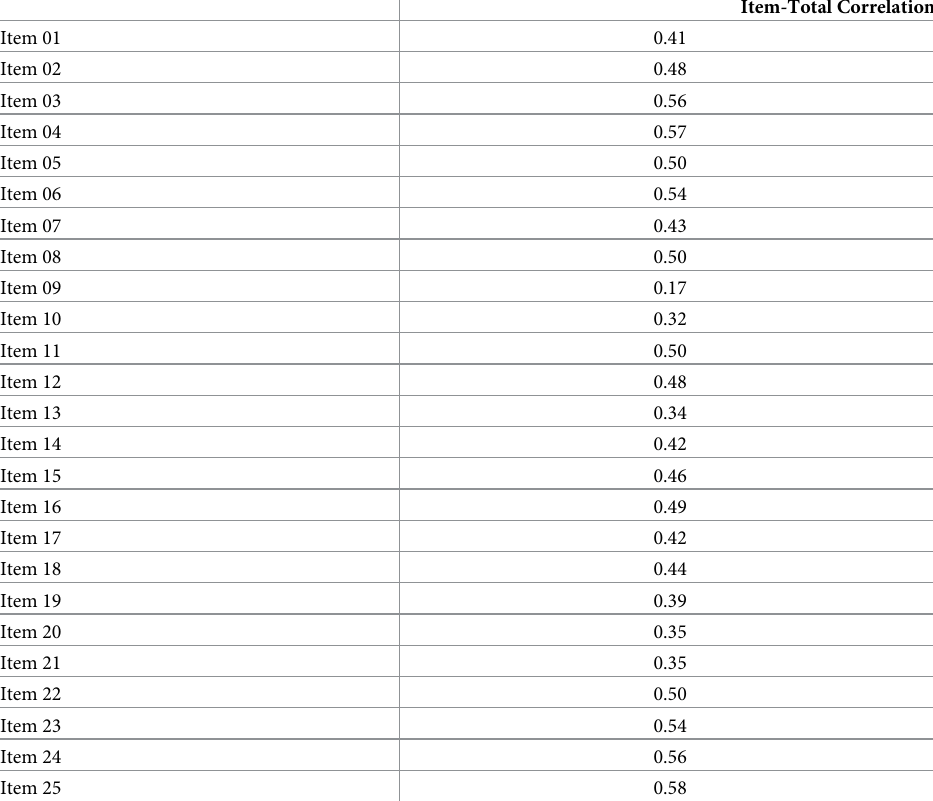
Table 3. Item-total correlation without the item